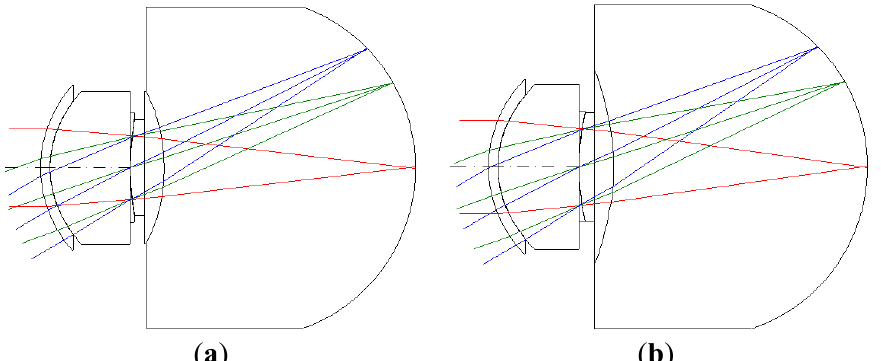
Figure 7. The 2D layout after applying the built-in optimization method in CODE V.